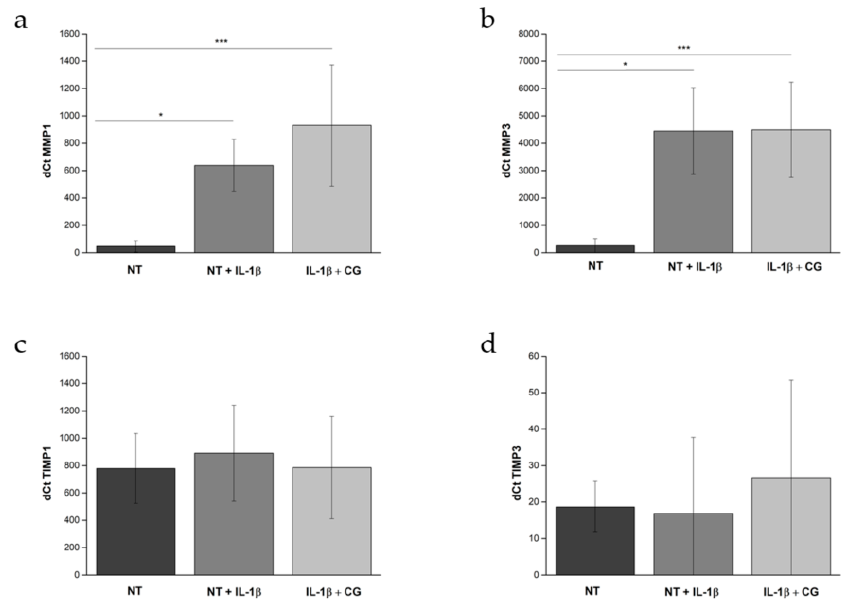
Figure 2. Expression of MMP1 , MMP3 , TIMP1, and TIMP3 . An inflammatory response was induced in chondrocytes by exposure to IL-1 β . Consequent exposure to CG 1.0 mg / mL (IL-1 β + CG) did not induce a significant change in the expression of MMP1 ( a ), MMP3 ( b ), TIMP1 ( c ), TIMP3 ( d ). NT: control (Not Treated). * p ≤ 0.05, *** p ≤ 0.001.